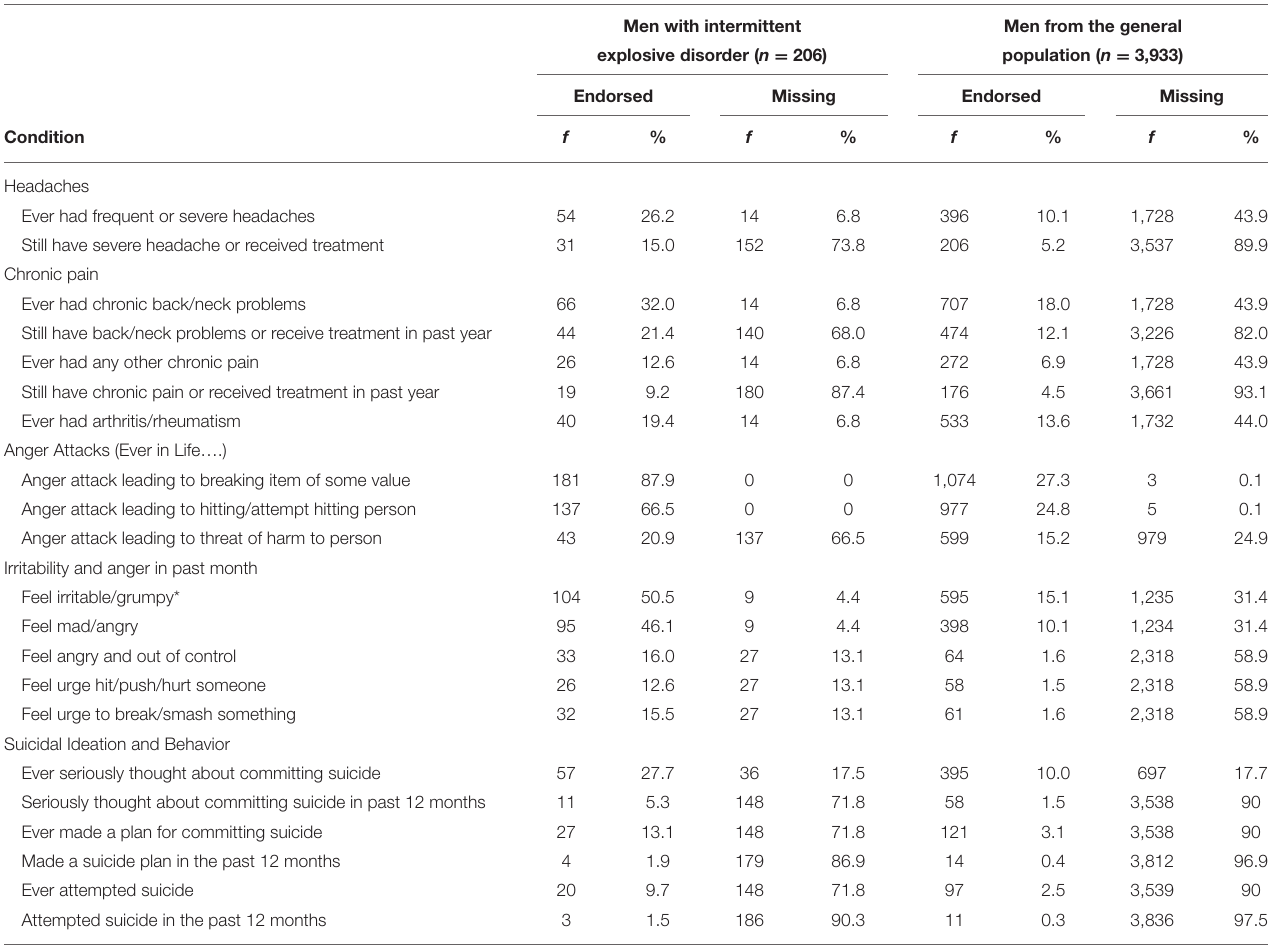
TABLE 2 | Headaches, chronic pain, anger, and suicidal behavior. Men with intermittent Men from the general explosive disorder ( n = 206) population ( n = 3,933) Endorsed Missing Endorsed